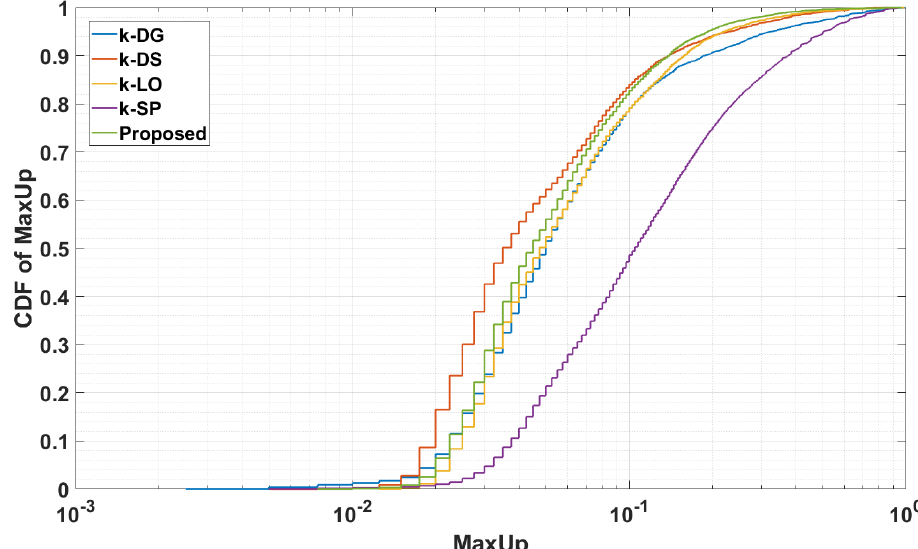
Figure 5. CDF of the attackers’ detectability/MaxUp of launching a DDoS Attack on an LEO satellite